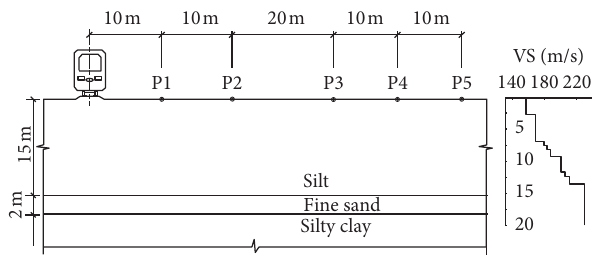
Figure 3: Cross section of the field test.